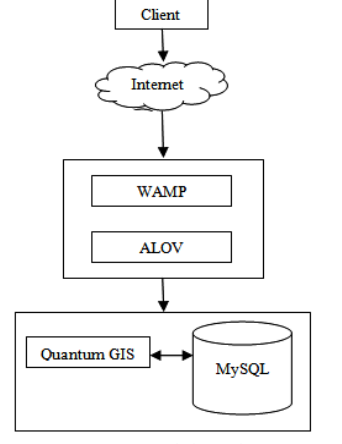
Figure 4: Framework based on